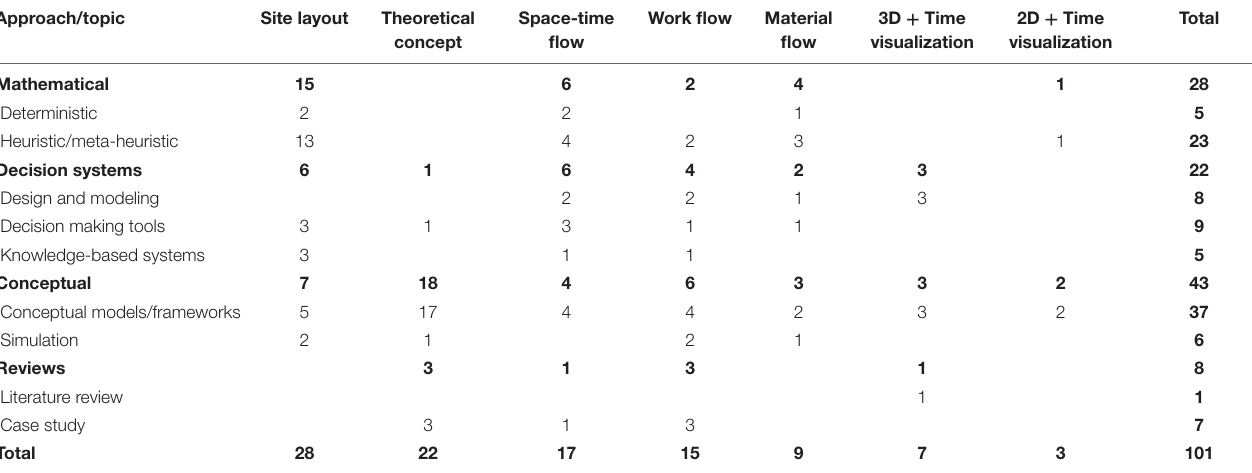
TABLE 1 | Matrix table of identified publications—Topic versus approach. Approach/topic Site